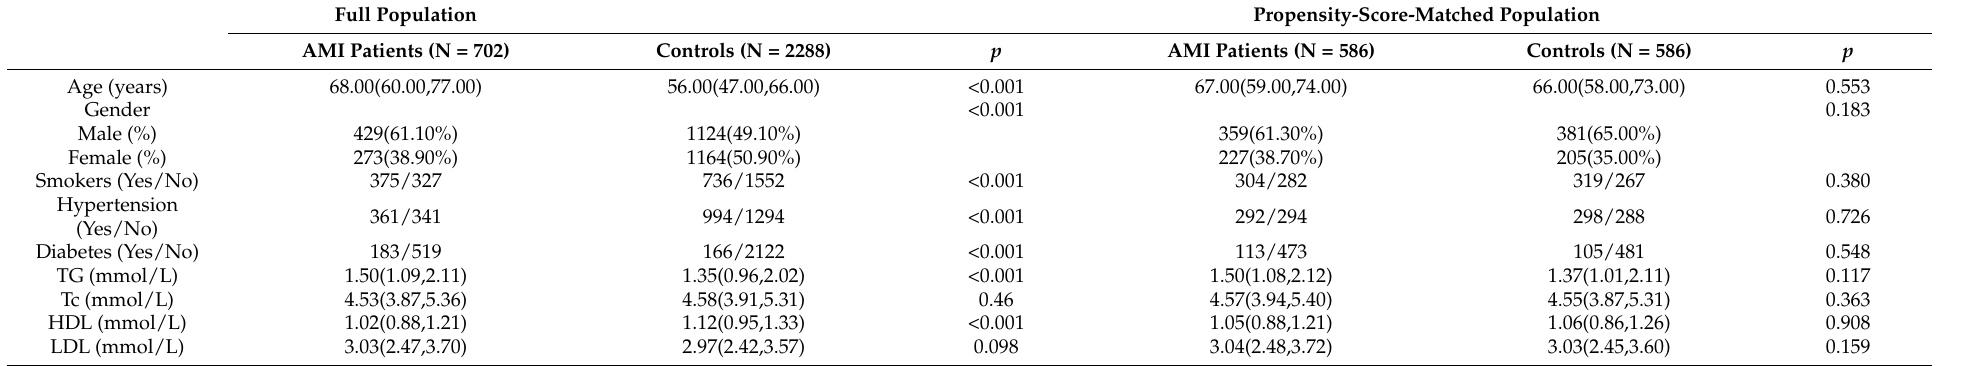
Table 1. Baseline characteristics and AMI-Controls risk factors in the study population.